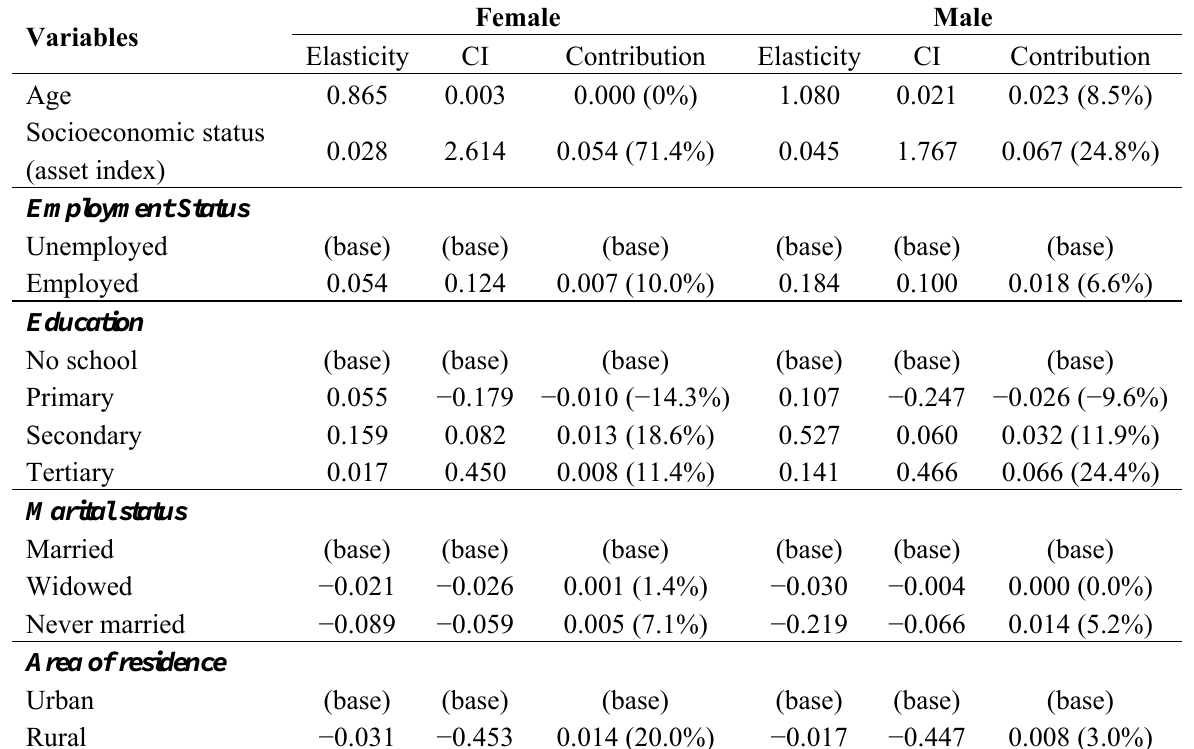
Table 4. Decomposition of concentration indices for women and